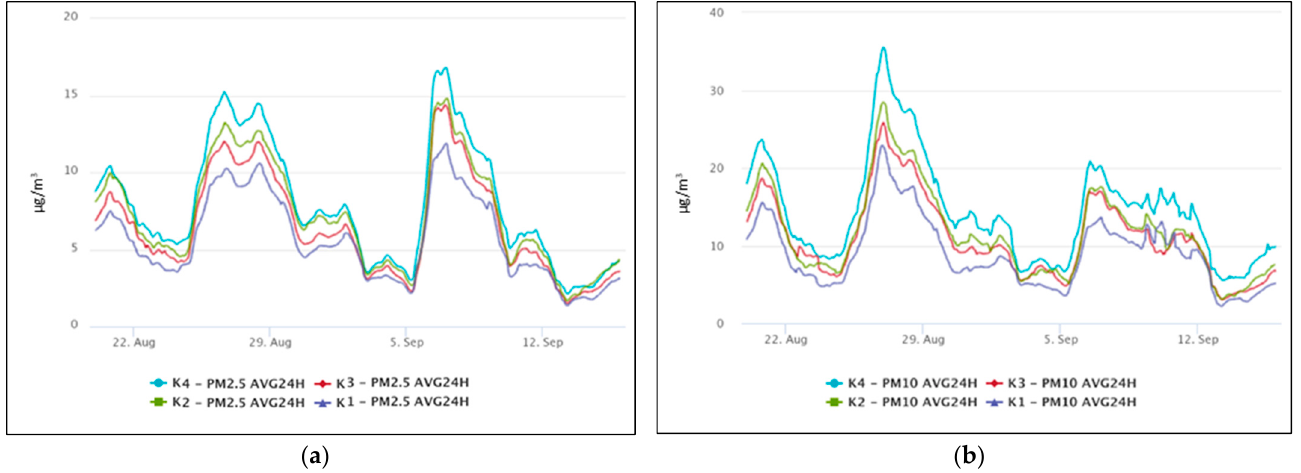
Figure 5. The 24 h average values of PM 2.5 ( a ) and PM 10 ( b ) in µ m/m 3 for each measurement location over the experimental period